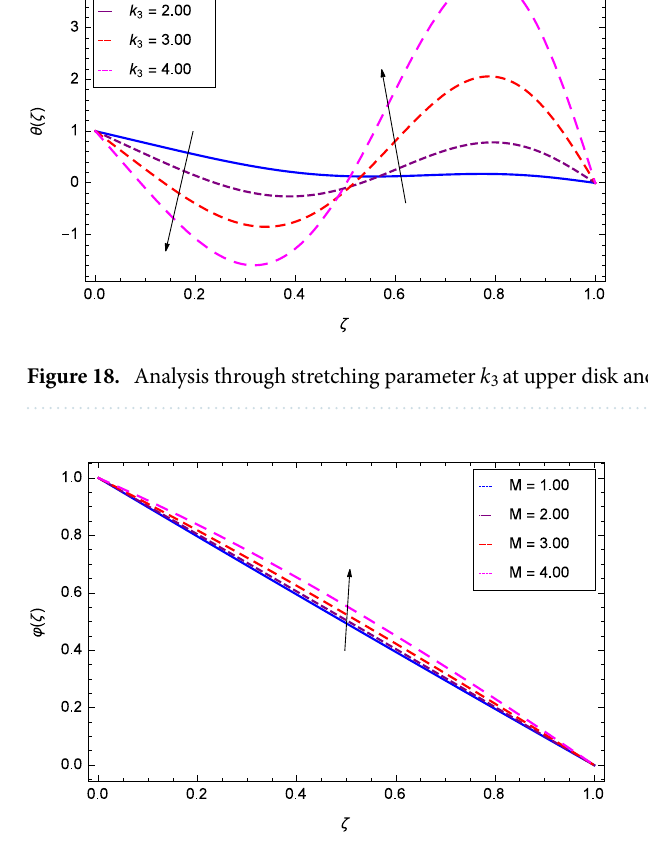
Figure 19. Analysis through magnetic field parameter M and nanoparticles concentration ϕ ( ζ ).